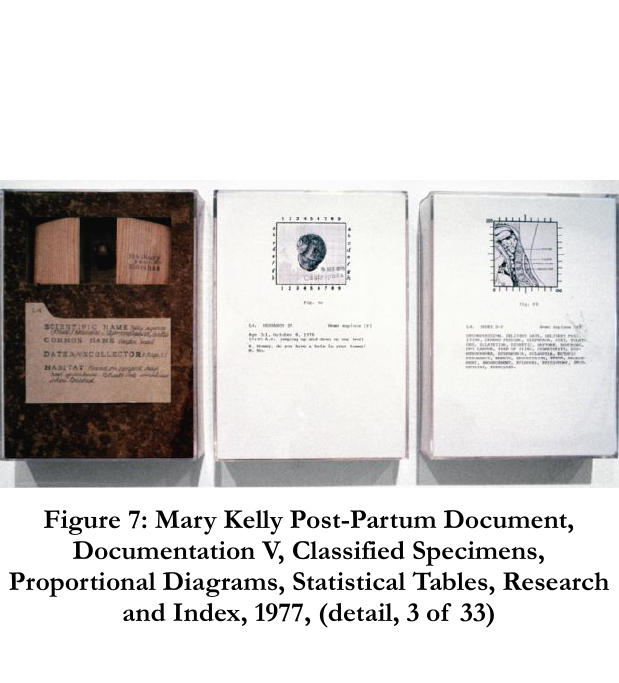
Figure 6: Mary Kelly Post-Partum Document, Documentation IV, Analysed Transitional Objects, Diary and Diagram, 1976, (detail, 1 of 8) 1976